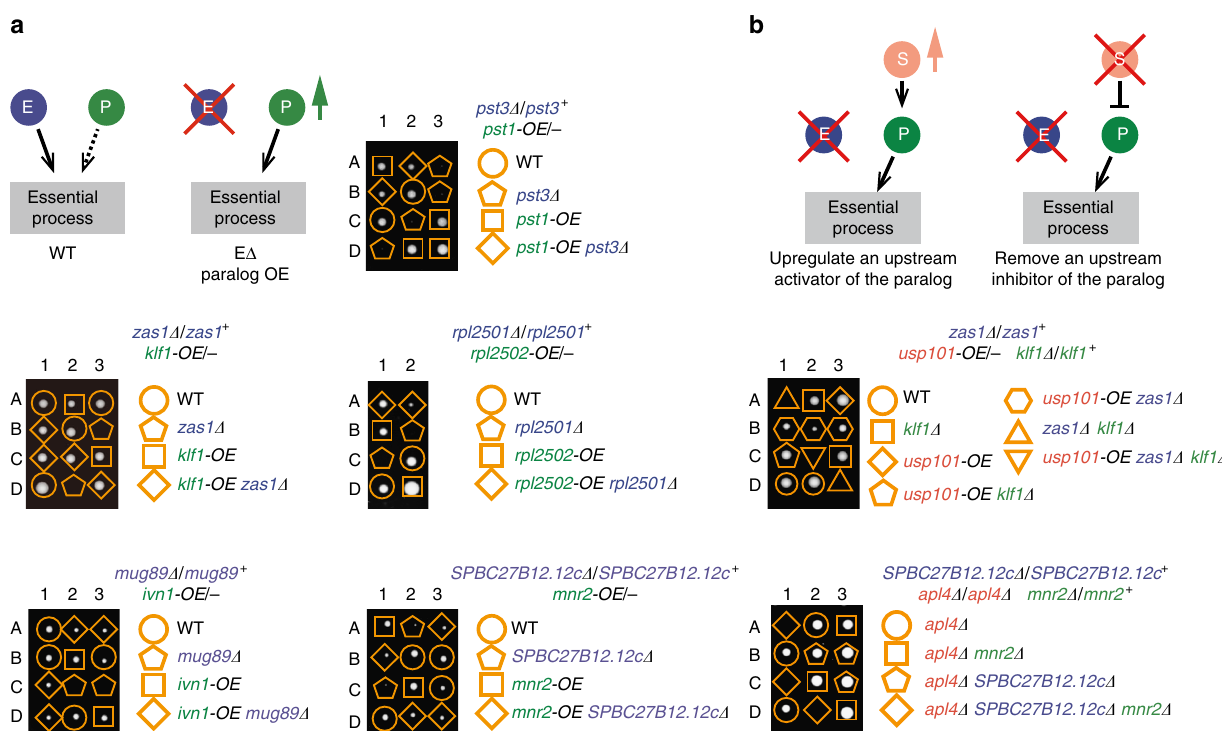
Fig. 5 Activating a dormant redundancy between paralogs is one mechanism of essentiality bypass. a Schematic illustrating how an essential gene ( ‘ E ’ in blue) can be rendered dispensable by the overexpression (OE) of its paralog ( “ P ” in green), and tetrad dissection showing that the essentiality of fi ve query essential genes can be bypassed by overexpressing their respective paralogs. b Two hypothetical scenarios of paralog-dependent bypass achieved by altering a non-paralogous suppressor gene ( “ S ” in orange) and two examples of paralog-dependent